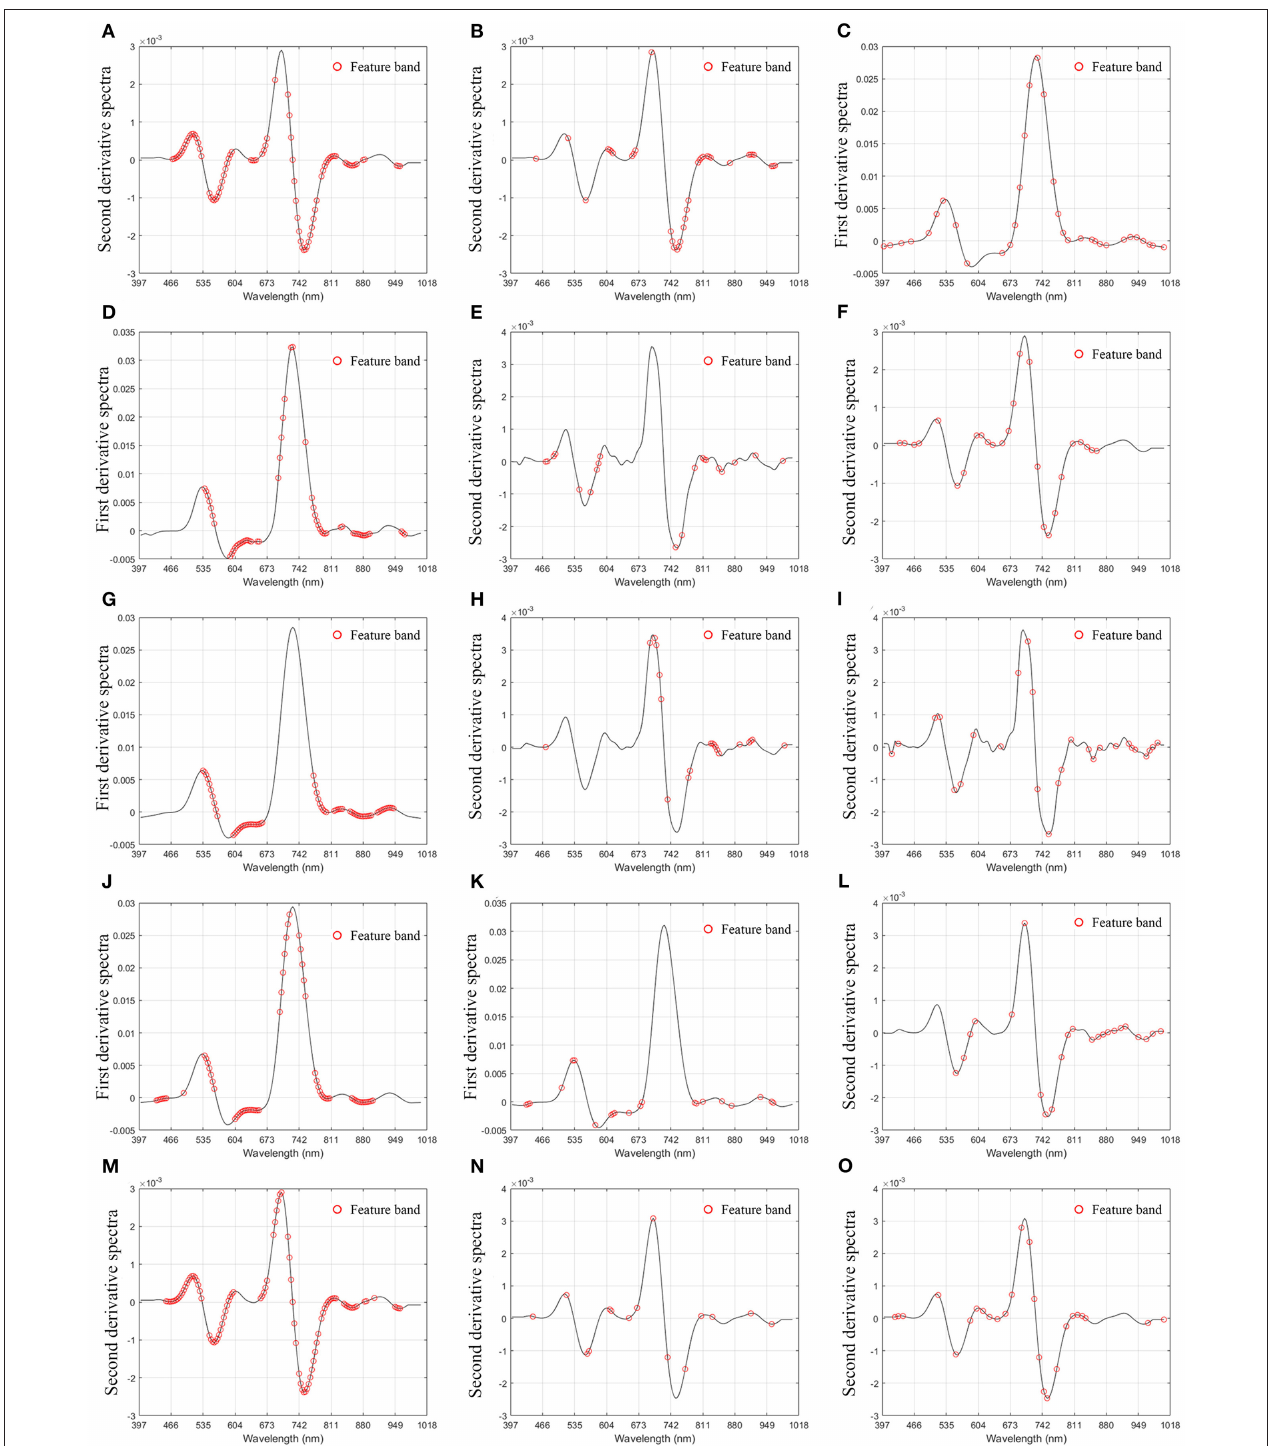
FIGURE 5 | Distribution of characteristic bands. (A) Malondialdehyde-uninformative variable elimination; (B) . Malondialdehyde-competitive adaptive reweighted sampling; (C) . Malondialdehyde-successive projections algorithm; (D) . Electrolyte leakage-uninformative variable elimination; (E) . Electrolyte leakage-competitive adaptive reweighted sampling; (F) . Electrolyte leakage-successive projections algorithm; (G) . Fv/Fm -uninformative variable elimination; (H) . Fv/Fm -competitive adaptive reweighted sampling; (I) . Fv/Fm -successive projections algorithm; (J) . Soluble saccharide-uninformative variable elimination; (K) . Soluble saccharide-competitive adaptive reweighted sampling; (L) . Soluble saccharide-successive projections algorithm; (M) . Drought damage degree-uninformative variable elimination; (N) . Drought damage degree-competitive adaptive reweighted sampling; (O) . Drought damage degree-successive projections algorithm.